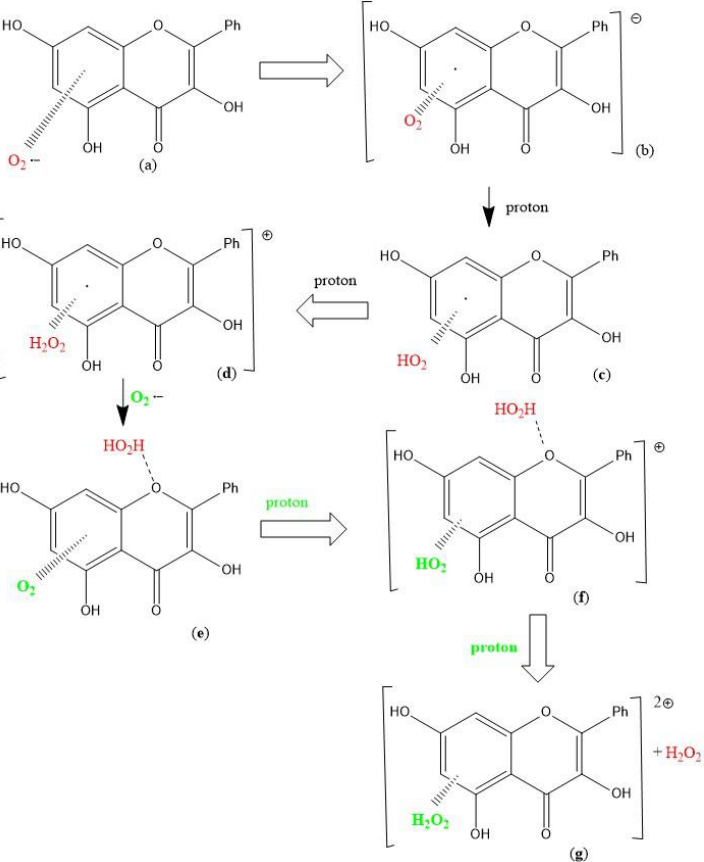
Scheme 2. Superoxide radical interaction with galangin [25]. The π - π scavenging of superoxide by galangin: ( a ) Superoxide interacts with galangin ring A ( π - π approach); ( b ) the unpaired electron enters the galangin ring; ( c , d ) two protons are incorporated within the O 2 moiety forming H 2 O 2 ; ( e ) a 2nd superoxide is incorporated, ( f ) a proton captured by O 2 forms a HO 2 moiety; ( g ) after an additional proton the original H 2 O 2 (red) detaches from O-1 galangin position.